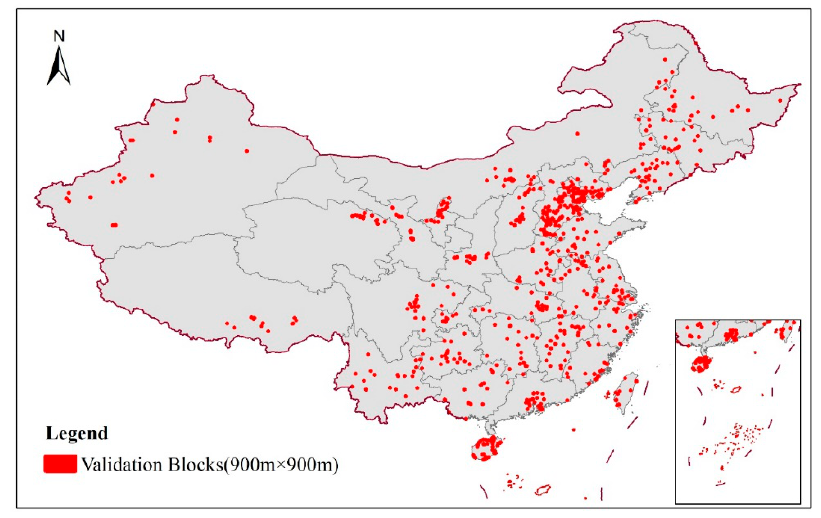
Figure 8. Validation blocks of 900 m × 900 m in China.